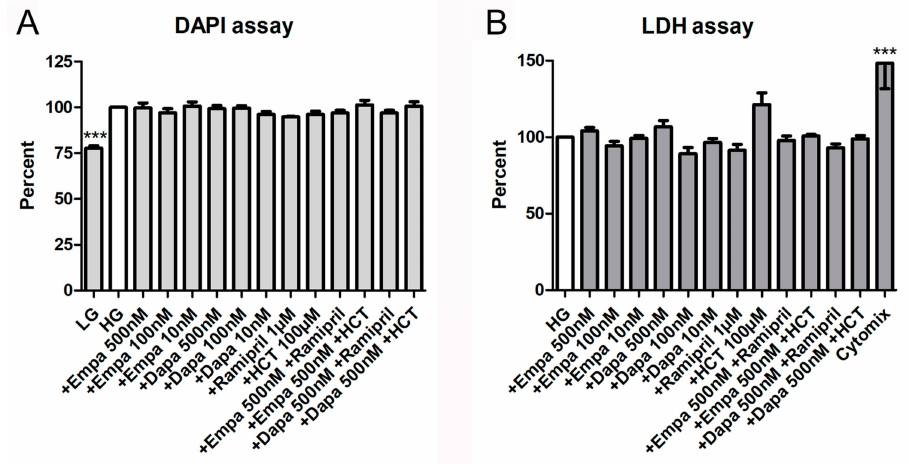
Figure 4. Cell proliferation and cytotoxicity assays. ( A ) DAPI assay. The assay was used to measure the DNA content as an indirect determination of cell number and proliferation [17]. Fluorescence was measured using a fluorescence reader (ex 355 nm, em 460 nm, arbitrary units, calculated as percent in relation to the control (HG), mean ± SD, n = 4). Cells cultured in LG were used as a negative control. ( B ) Lactate dehydrogenase (LDH) assay. The measurement of LDH activity released from the cytosol of damaged cells into the supernatant was used for the quantification of cell death and cell lysis. Absorbance was measured in a microplate reader (490 vs. 650 nm, arbitrary units, calculated as percent in relation to the control (HG), mean ± SD, n = 4–6). A mixture of pro-inflammatory cytokines was used as a positive control (*** p <